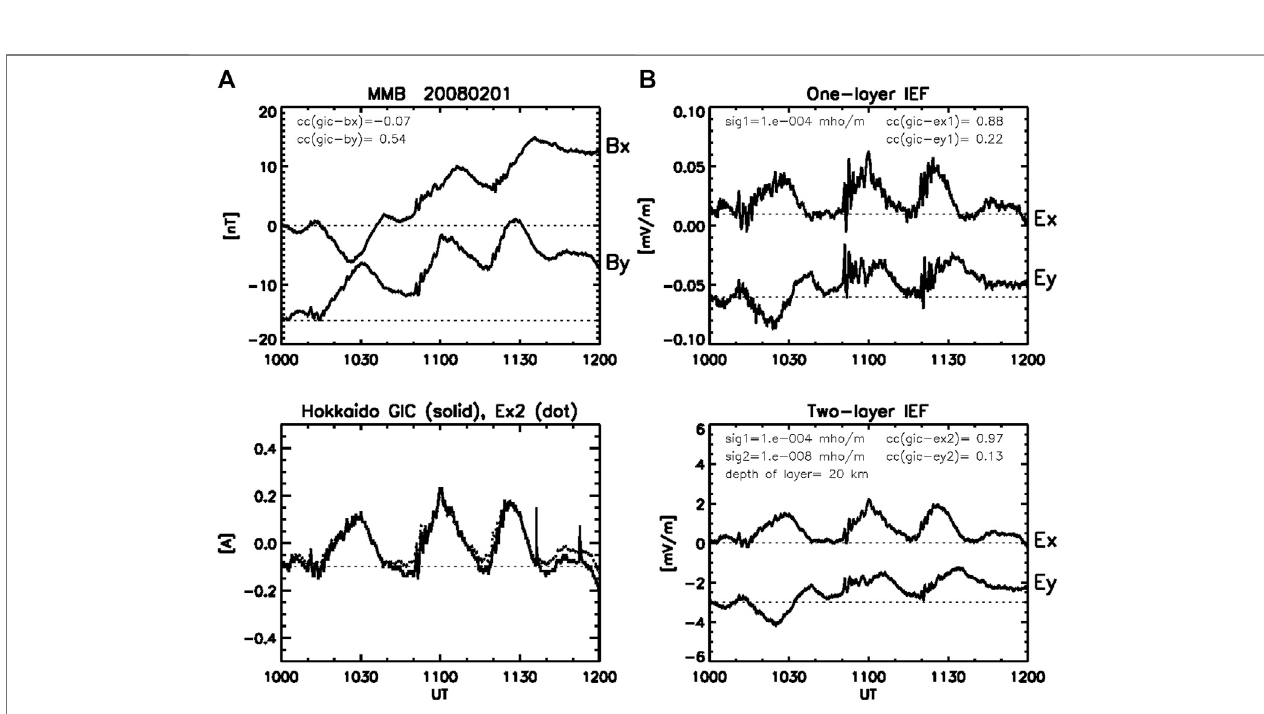
FIGURE3|(A) B x , B y andGICobservedatMMB,and (B) E x and E y calculatedintheone-andtwo-layermodelsfortheDP2 fl uctuationeventwithperiodsof30 min in the evening sector (10-12 UT, 19-21 MLT). The parameters and formats of the plots are the same as in Figure 1 .